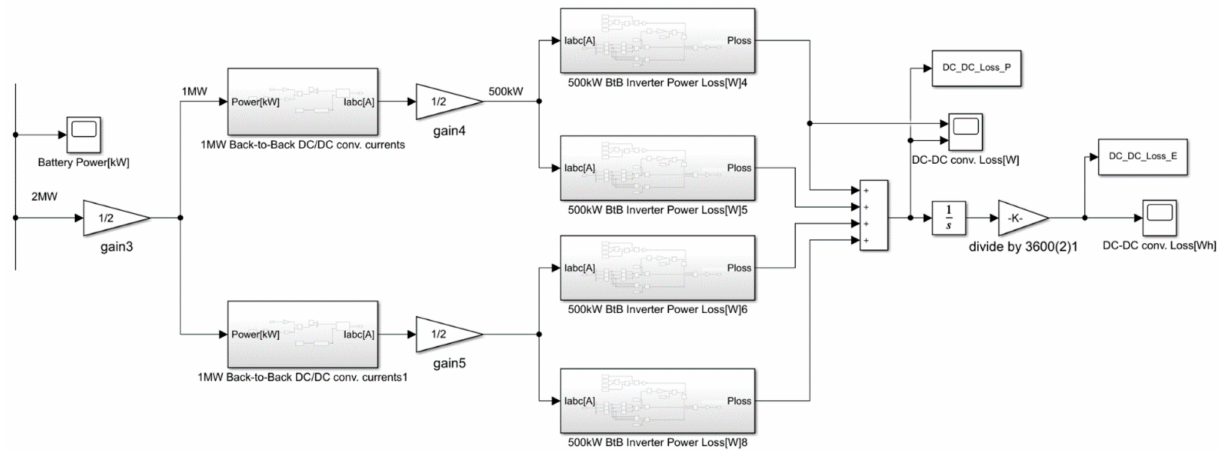
Figure 22. MATLAB/ SIMULINK model of 1 MW DC/DC converter power